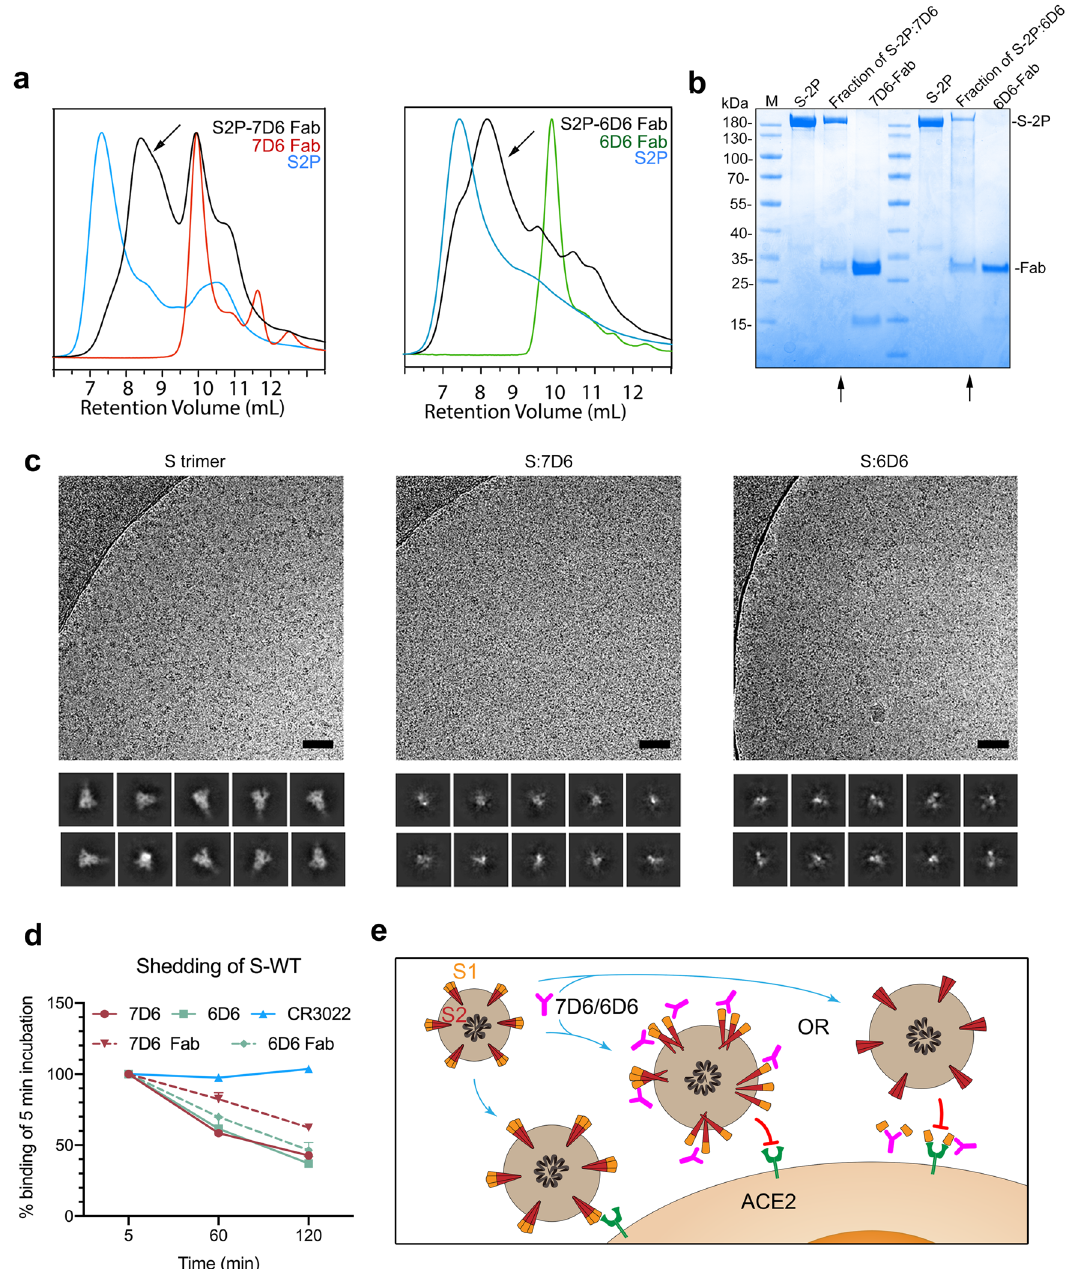
Fig. 6 Neutralization mechanism revealed by biochemical and cryo-EM analyses. a HPLC pro fi les of 7D6 and 6D6 binding to the S trimer. The black peak (arrow) indicates depolymerization of the spike. b SDS-PAGE analysis of the fractions harvested from the gel fi ltration chromatography of the mixture of S-2P and 7D6 or 6D6 Fab. The fractions are the peaks indicated by arrows in HPLC pro fi le. c Cryo-EM micrographs (upper) and 2D analysis (lower) of S-2P and its immune complexes. Scale bar = 50 nm. d Shedding of S1 by IgG- and Fab forms of nAbs measured at 293 T cell-surface decorated with SARS-CoV- 2 wild-type S protein by fl ow cytometry. e Two possible mechanisms of 7D6/6D6-mediated neutralization. First, 7D6/6D6 destabilizes SARS-CoV-2 spikes on the virus surface and the disordered spikes lose ability to engage ACE2 receptor. Or second, 7D6/6D6 binding triggers shedding off S1 moieties from S trimers, rendering viruses non-infectious, even though the free 7D6/6D6-bound S1 moieties could still engage ACE2. The experiments in ( b ) and ( c ) were performed twice with similar results. Source data are provided as a Source Data fi